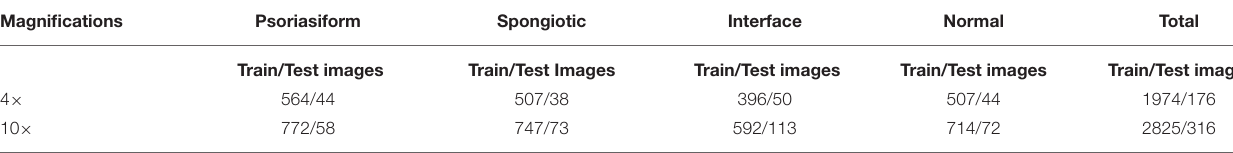
TABLE 1 | The details of superficial perivascular dermatitis